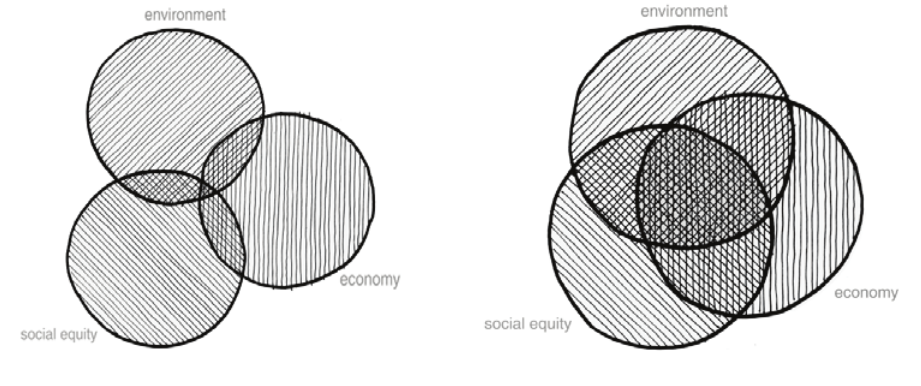
Figure 5. Overlapping spheres of economic, environmental and social sustainability. In the figure on the left, the action represented by the darkest area does not show significant consideration of all spheres. In the figure on the right, the action taken has met the needs of much of each sphere, representing a more sustainable choice (Sands,